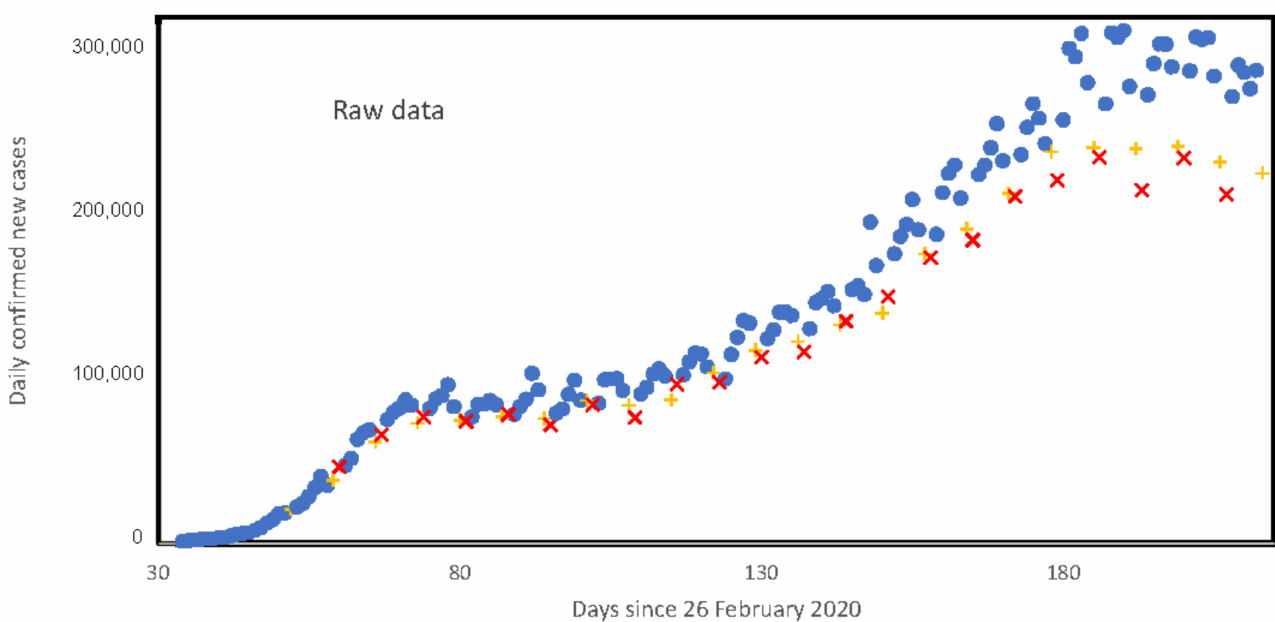
Figure 7. Confirmed world daily new cases (from [30]) as a function of days since 26 February until 23 August 2020 + indicates Sundays, X indicates Mondays.